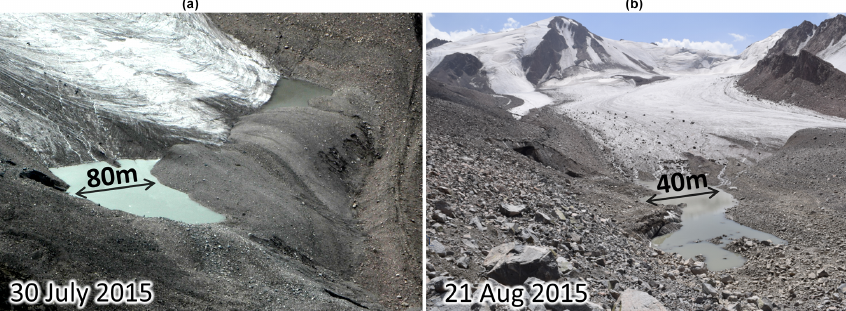
Figure 3. Korumdu glacial lake on 30 July 2015 (from a helicopter) and 21 August 2015 (from field observation). Lake width at mid-length is about 80m (a) and 40m (b) .